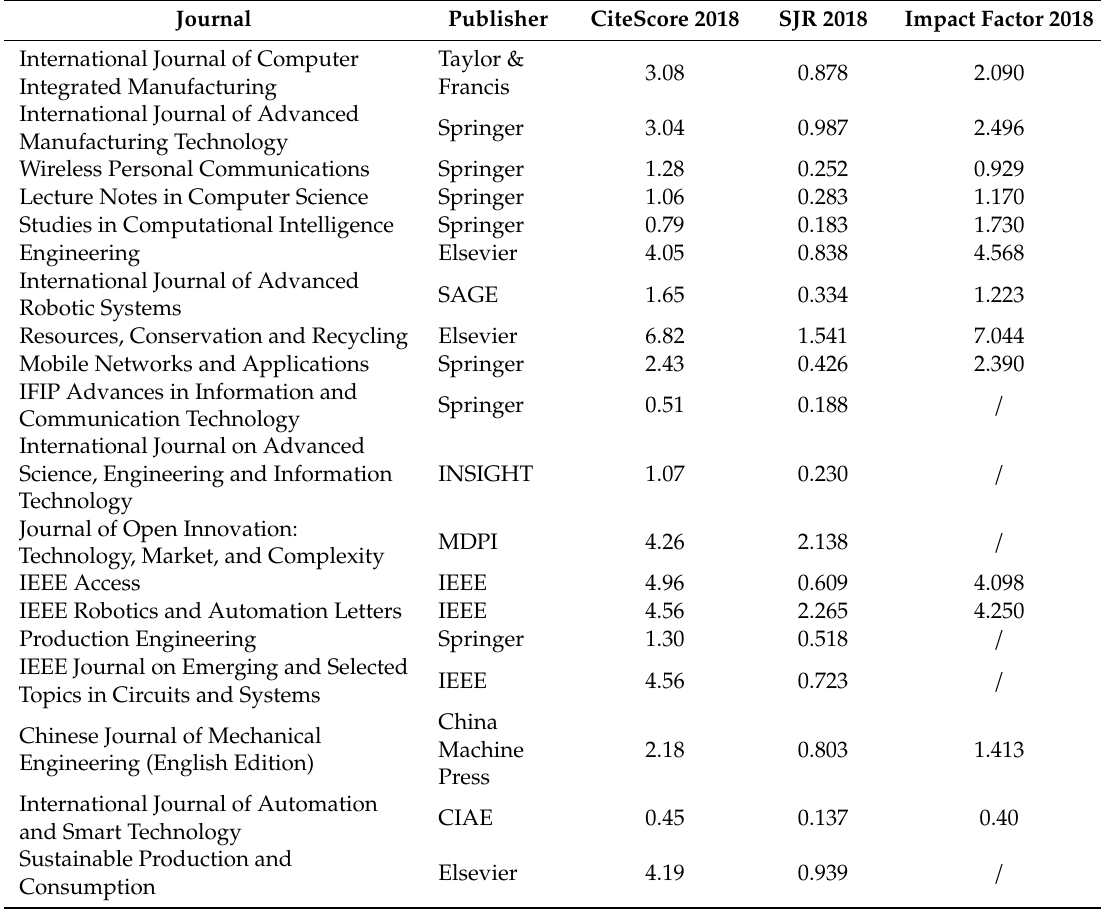
Table 1. Journal ranking (source: Scopus).